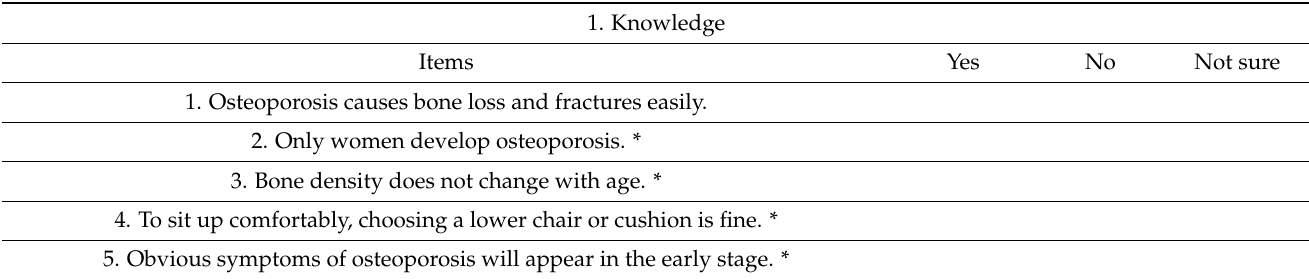
Table 3. The final version of